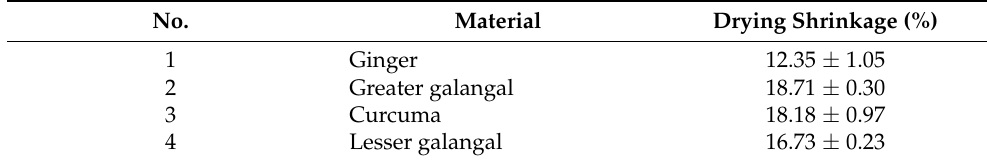
Table 7. Drying shrinkage in final products of different medicinal plant samples dried in the Polydryer with the operation of a